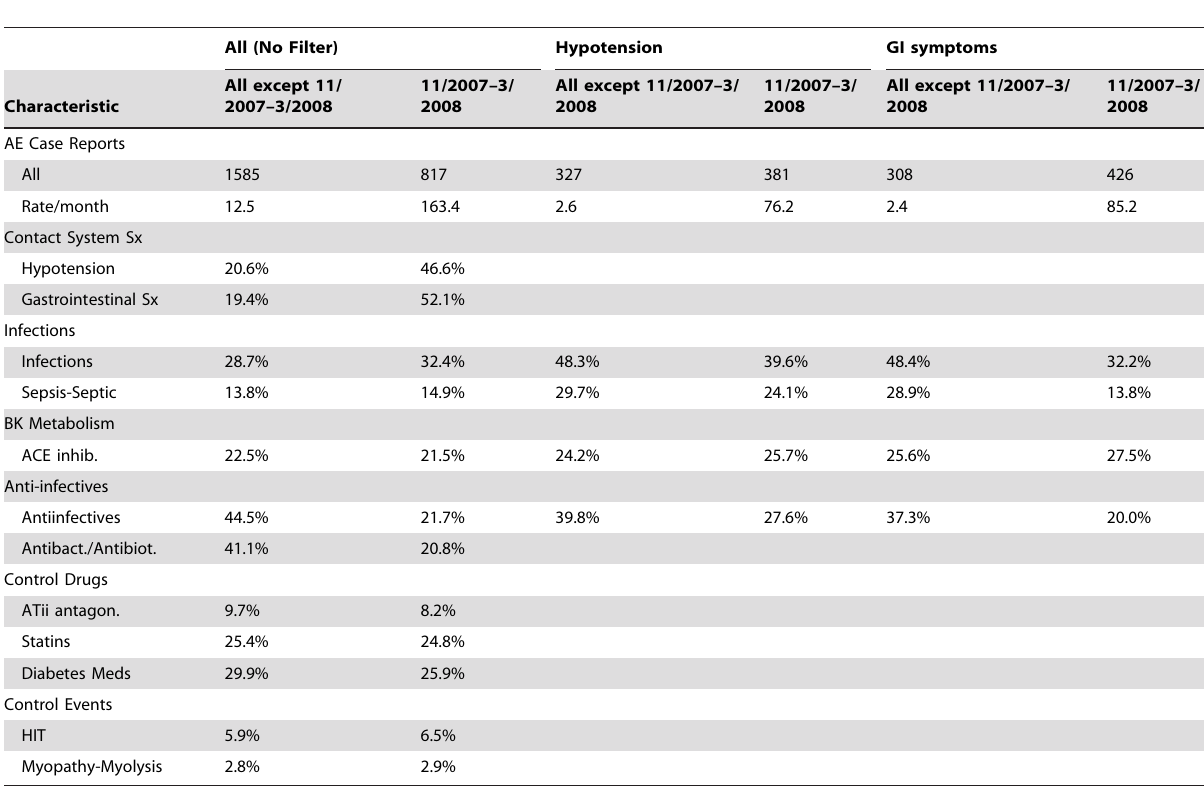
Table 1. Characteristics of AE associated with Heparin & Dialysis